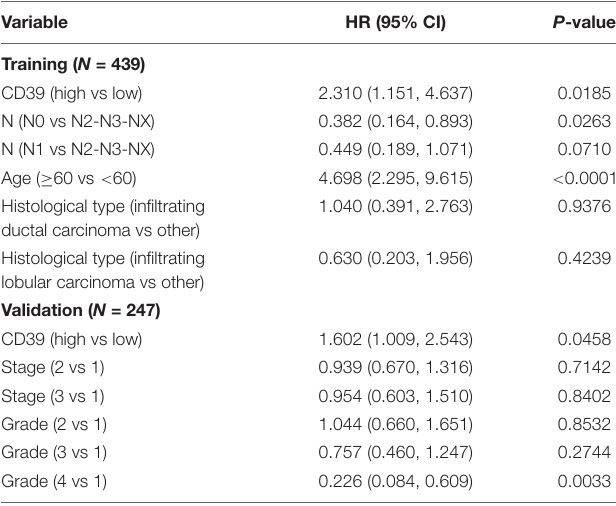
TABLE 3 | Multivariate analysis for luminal molecular type breast cancer patients using Cox regression.